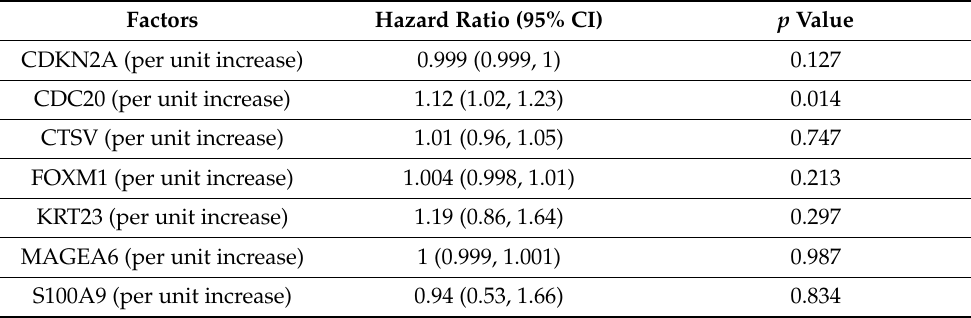
Figure 10. ROC curve for ( A ) CDKN2A, ( B ) CTSV, ( C ) FOXM1, and ( D ) KRT23 with AUC = 0.9879 for CDKN2A, AUC = 0.8152 for CTSV, AUC = 0.8909 for FOXM1, and AUC = 0.7273 for KRT23, respectively. Table 5. Univariate analysis of gene expression on overall survival using Cox model.